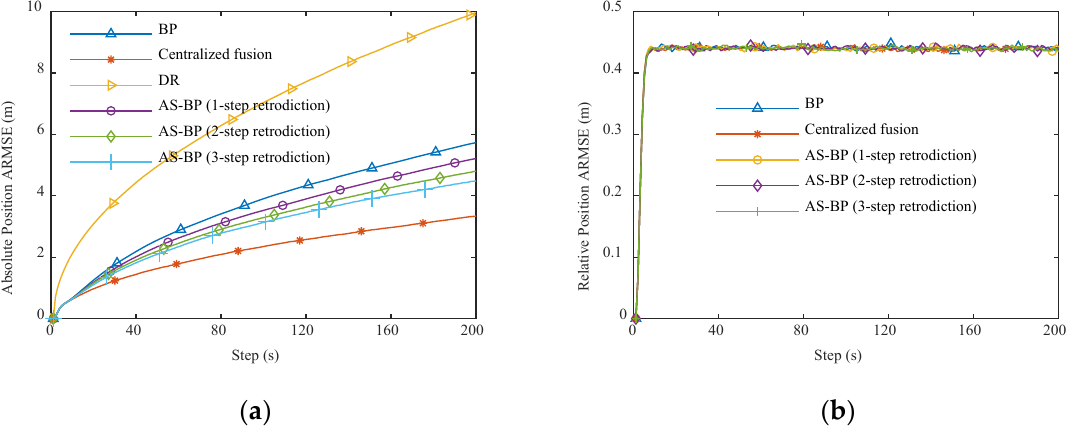
Figure 4. Absolute and relative position RMSEs in fully connected topology. ( a ) Absolute position RMSE. ( b ) Relative position RMSE.